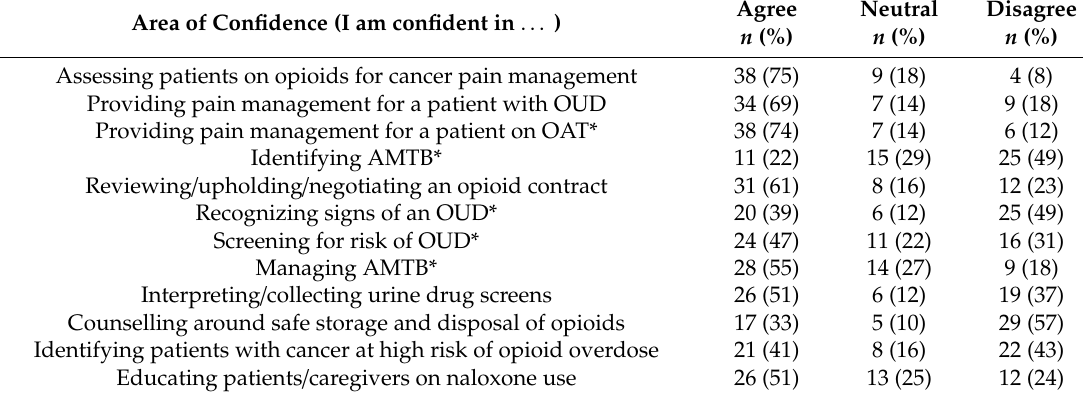
Table 2. Level of confidence in opioid management and risk mitigation by number and percentage of participants ( n = 51).